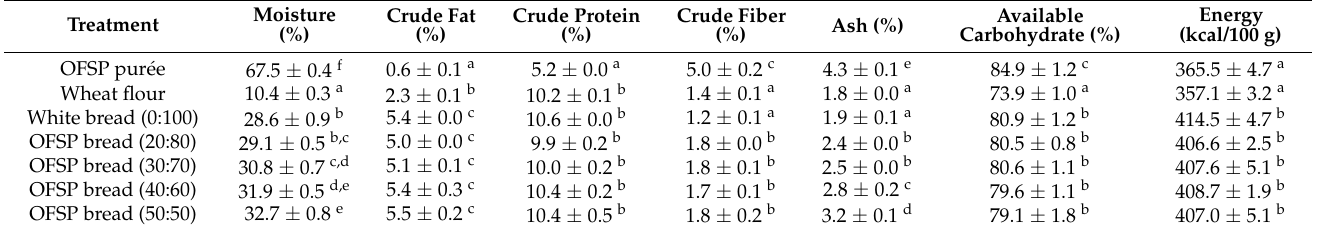
Table 2. Proximate composition of raw ingredients and OFSP pur é e–wheat flour composite bread (DWB) 1